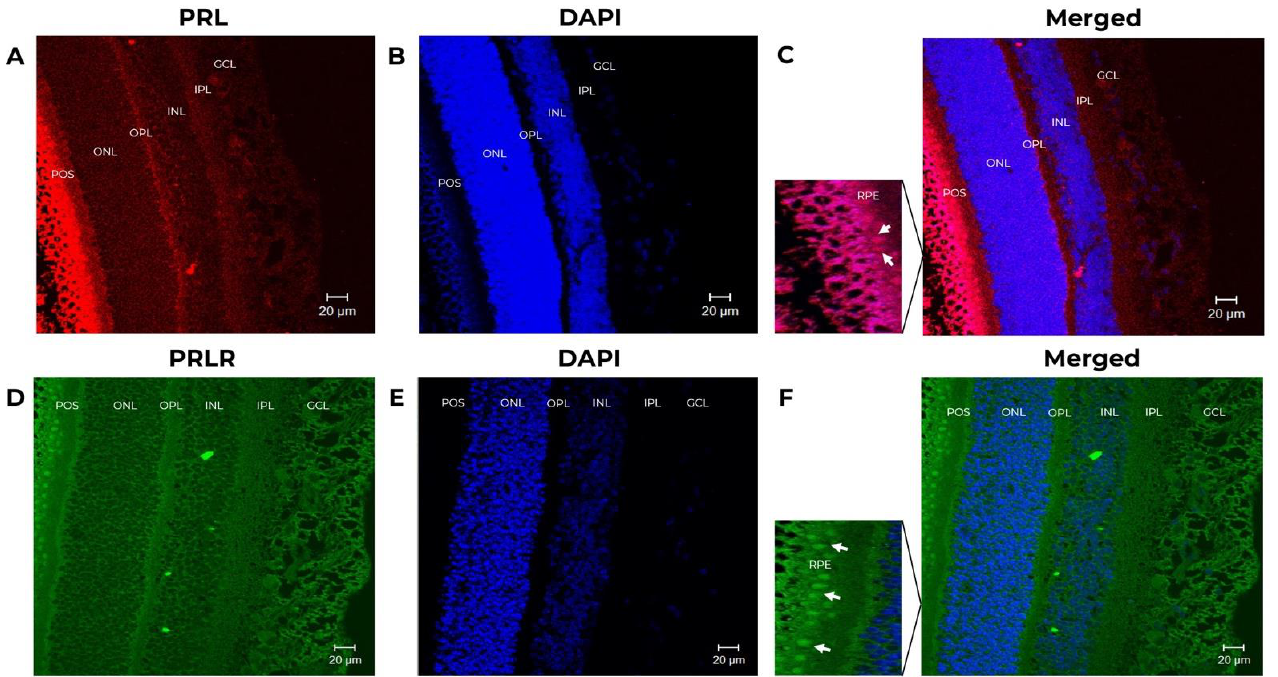
Figure 3. Prolactin (PRL) and prolactin receptor (PRLR) immunoreactivity in the neural retina in baboon fetus. The tissues correspond to fetus baboon ID 12354. Confocal images of immuno-stained retina sections identified cells expressing PRL and PRLR. ( A ) PRL expression (red, 1st Ab: mouse anti-human PRL 1:100; goat anti-mouse IgG Cy5 1:4000) in the retina of baboon fetus. ( B ) Stained retina sections with DAPI to counterstain nuclei (blue) at 25X magnification, scale- bar 20 μm. ( C ) Merged images of stained retinal sections to show PRL expression and DAPI, at 25X magnification, scale- bar 20 μm. ( D ) Cells expressing PRLR (green, 1st Ab: mouse anti-human PRLR 1:250; goat anti-mouse IgG-FITC 1:250). In the magnification the expression of PRL is positive (white arrows indicate the PRL positive cells). ( E ) Retinal sections stained with DAPI (nuclei in blue) at 25X magnification, scale- bar 20 μm. ( F ) Merged images to show PRLR expression and DAPI, at 25X magnification, scale- bar 20 μm. In the magnification the expression of PRLR is positive (white arrows indicate the PRLR positive cells) GCL (ganglion cell layer), INL (inner nuclear layer), ONL (outer nuclear layer), IPL (inner plexiform layer), OPL (outer plexiform layer), RPE (retinal pigmented epitelium), and POS (photoreceptor outer segment).